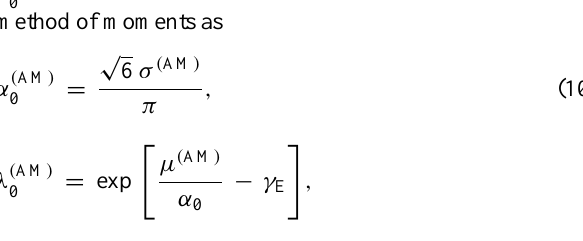
to variations of T